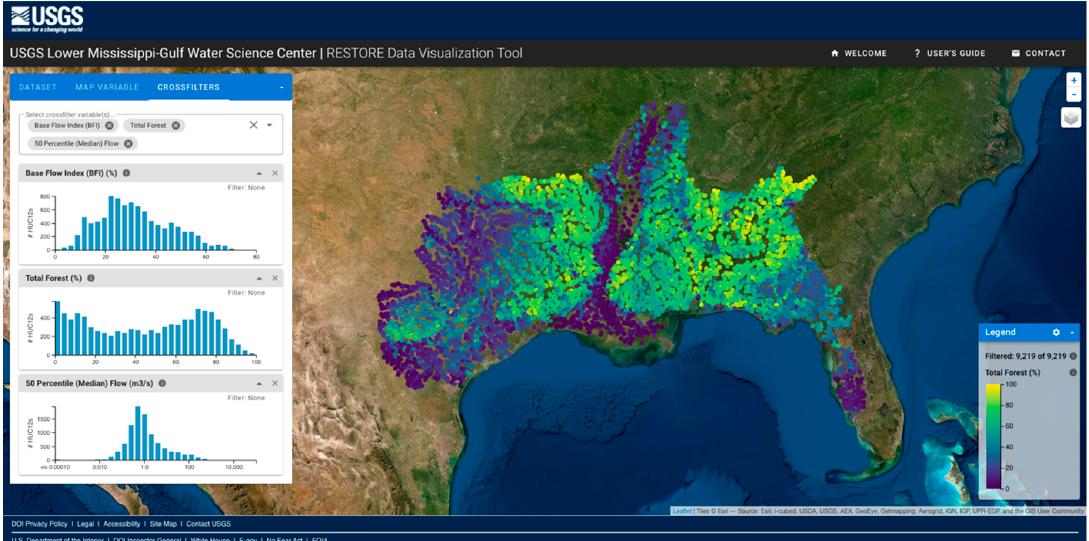
Figure 8. Screenshot of the ICE web application for streamflow conditions and alteration in the lower Mississippi-Gulf region showing the forest cover of each HUC12 basin pour point and crossfilters for the base-flow index, total percent forest cover and estimated median streamflow. Available at https://www.usgs.gov/apps/ecosheds/lmg-restore/.